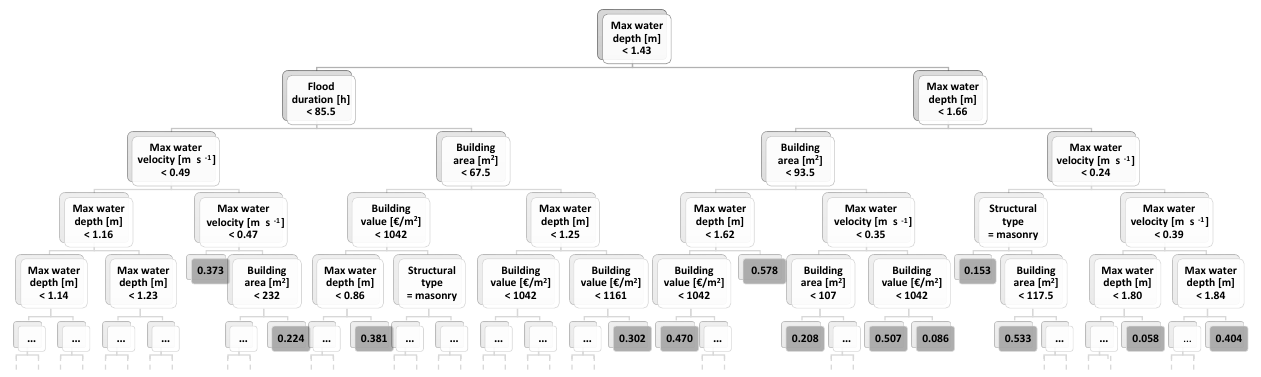
Figure B1. Example of a tree built with the RF algorithm on the basis of the Secchia dataset. White boxes represent splitting nodes, together with the indication of the splitting variable and its splitting value; grey boxes represent final nodes and the estimation of the relative building damages of that branch. The tree is cut off at an arbitrary level for the sake of